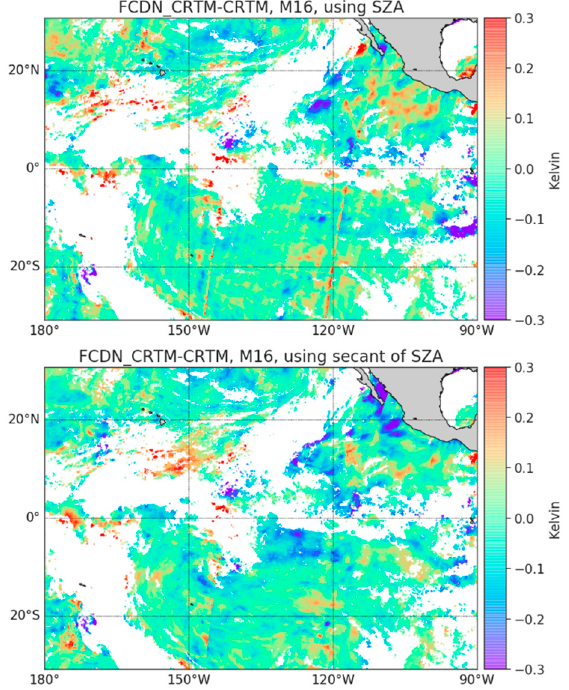
Figure 3. The distribution of the F-C mean biases in M16 with the direct SZA (upper) or secant of SZA (bottom) as an input feature in FCDN_CRTM